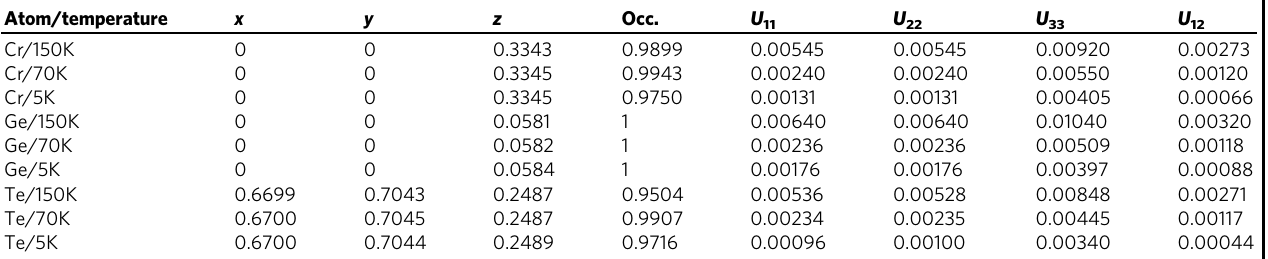
Table 1 Neutron diffraction re fi nement results at 150, 70, and 5 K. Atom/temperature